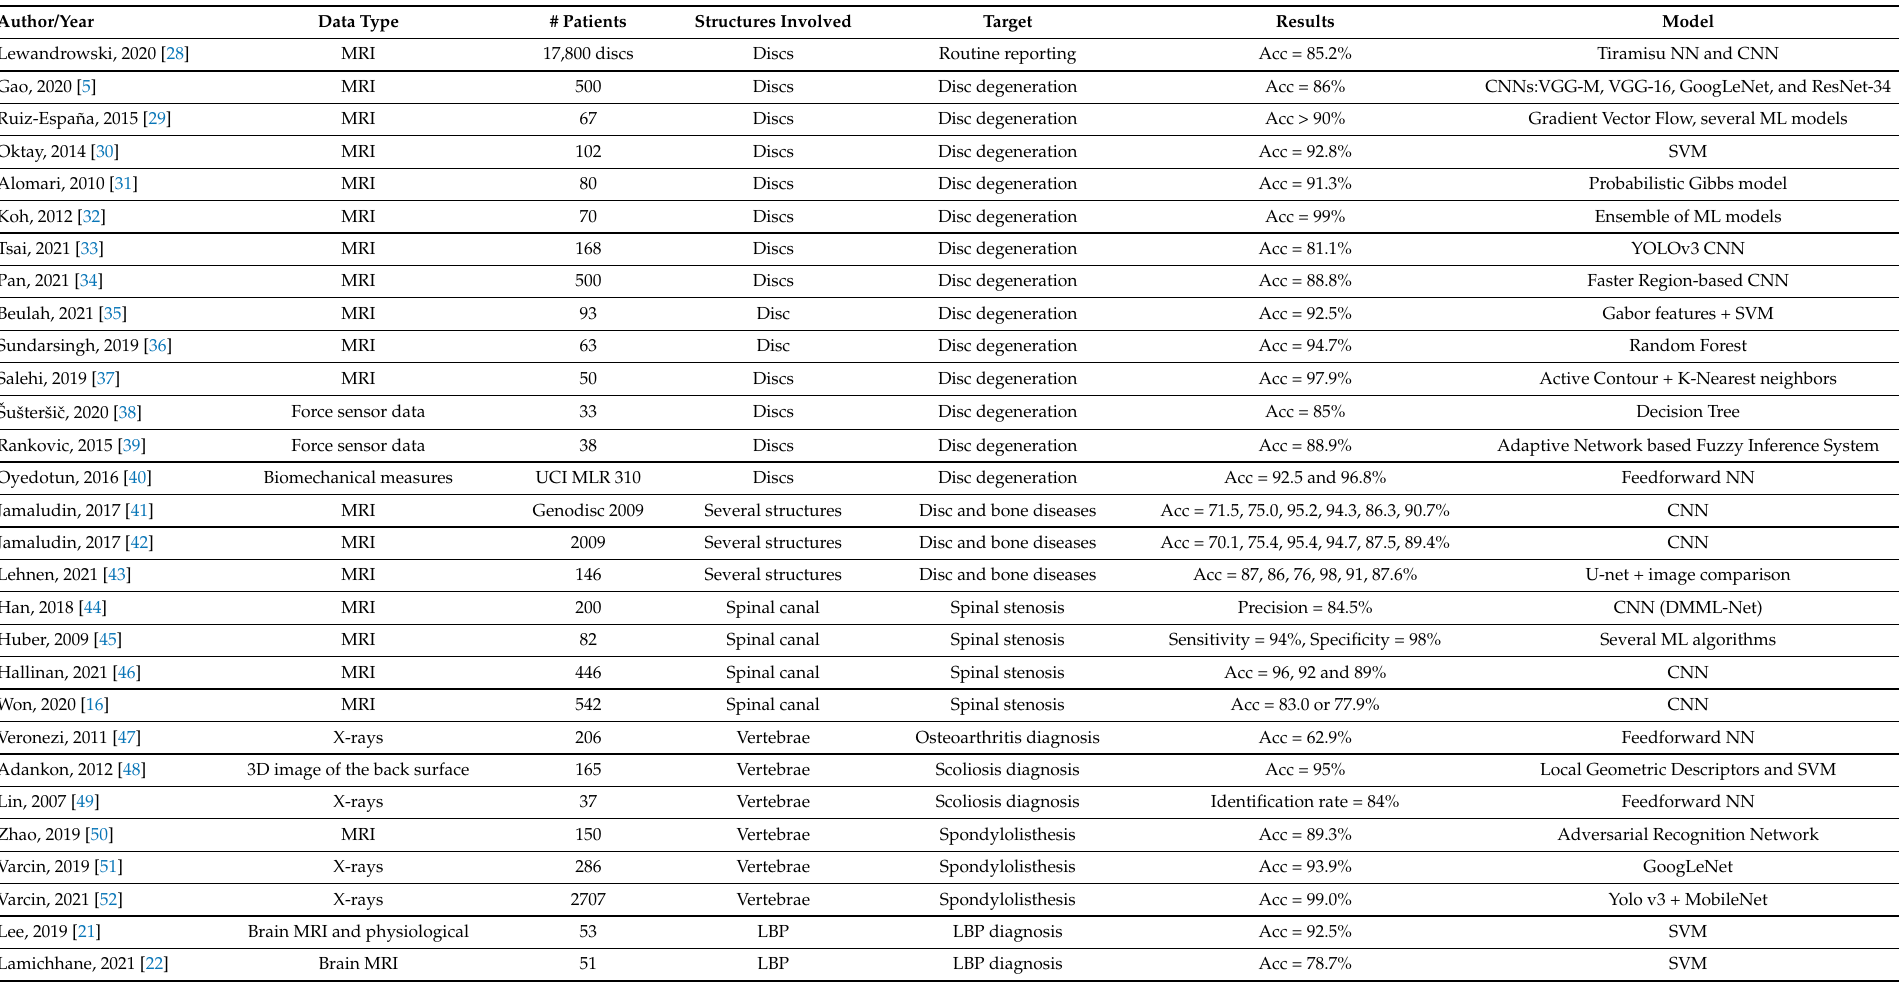
Table 2. Summary Table of the works performing Classification. If more than one structure/task were investigated in a study, the correspondent results are reported in the same order in which the structures are presented in the “Structures involved”/“Target”